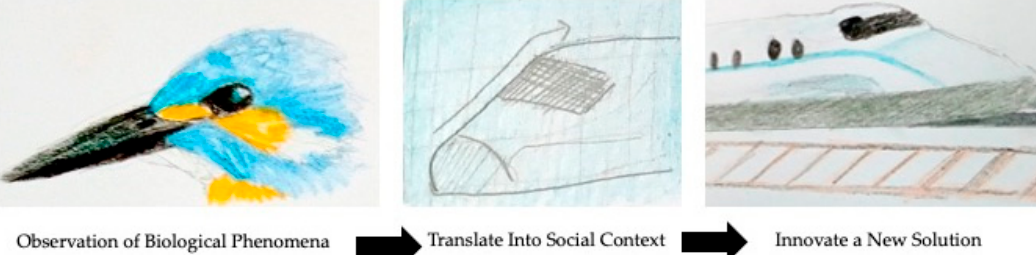
Figure 1. Basic bioinspired innovation process.